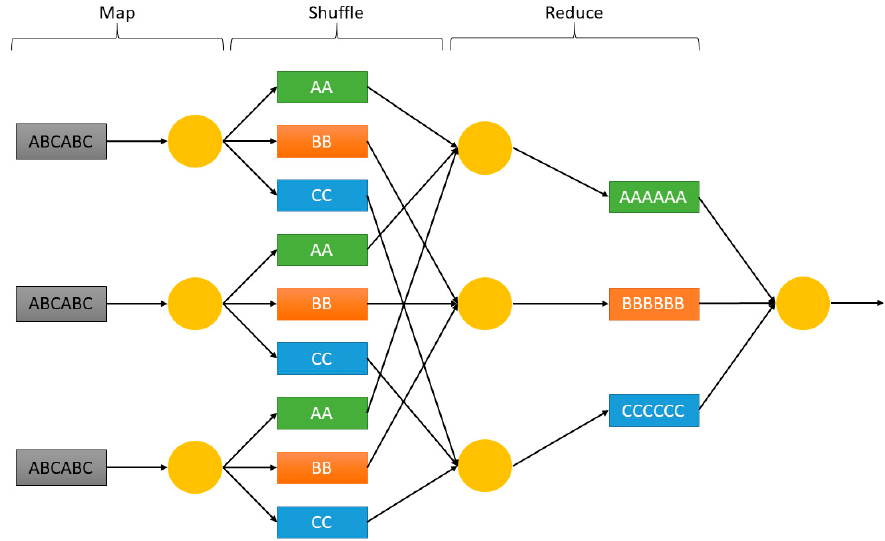
Figure 5. MapReduce Processing Model.